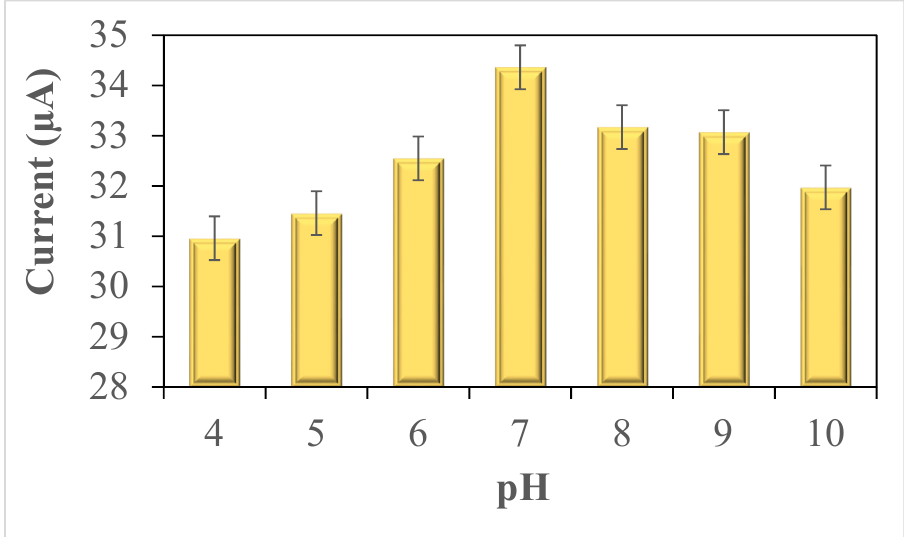
Figure 7. Effect of various pH on the analytical performance of the MIP-based electrochemical biosensor.